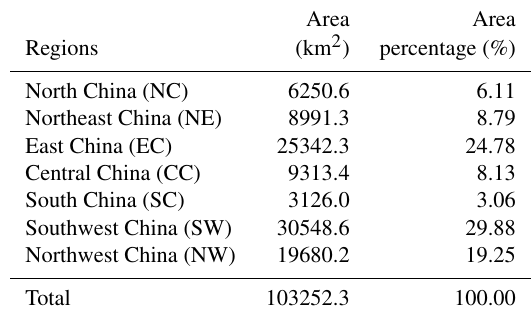
Figure 6. Annual change of total water area during the period of 2000–2016.